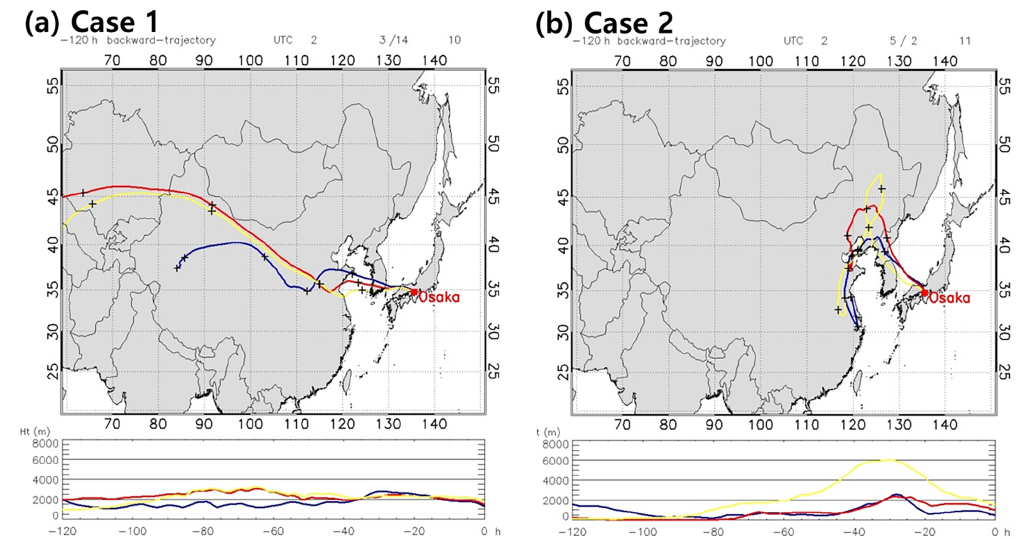
Figure 14. HYSPLIT 5-day backward trajectories of dust plumes for case 1 (a) and case 2 (b) . The start heights for case 1 are 1200m (blue), 1500m (red), and 1800m (yellow). For case 2 they are 500m (blue), 1000m (red), and 1500m (yellow). The start time is 00:00UTC in each